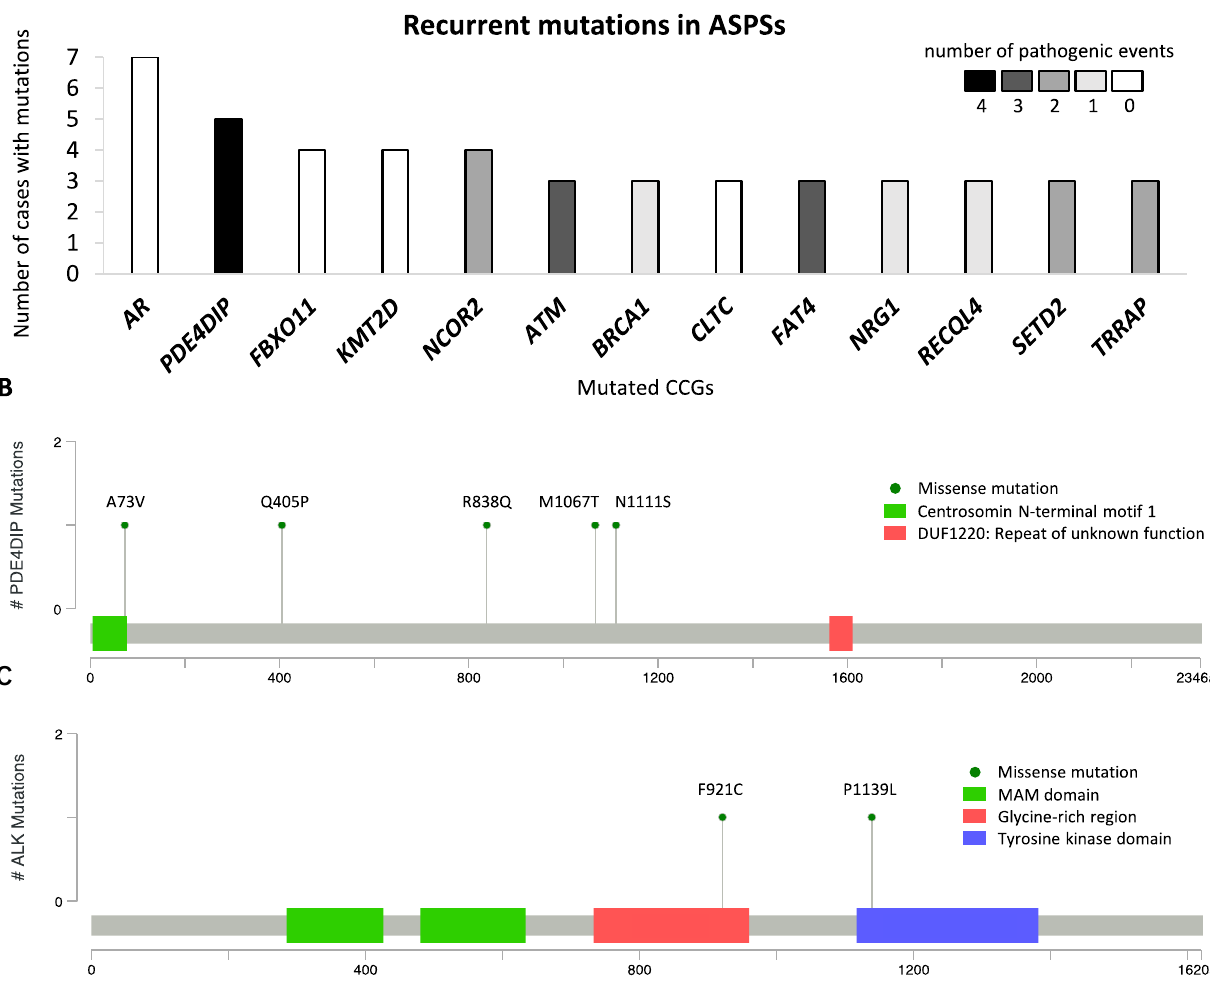
Figure 3. Mutational profile in alveolar soft part sarcoma, with recurrent mutations identified in 34 cases. ( A ) Cancer consensus genes altered by nonsynonymous mutations in at least 3 of 34 patients with alveolar soft part sarcoma. The y -axis represents the number of cases with nonsynonymous mutations, and the x -axis represents mutated genes. The number of predictively pathogenic events is coded in grayscale. The lollipop plots mapped the mutations in ( B ) PDE4DIP and ( C ) ALK on the linear protein sequence and their domains (colored boxes). The Y -axis represents the number of cases with mutations, The x -axis represents the amino acid sequence of mutated genes, and aa stands for amino